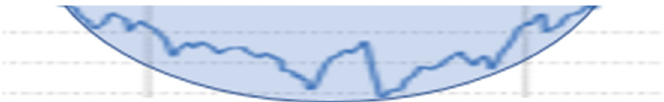
Figure 12. Schematic depiction of the capturing by a spherical segment of the calculated volume removal of material in comparison with the real volume removal of a complex figure bounded by a complex surface profile, calculated using an experimentally determined mass removal.